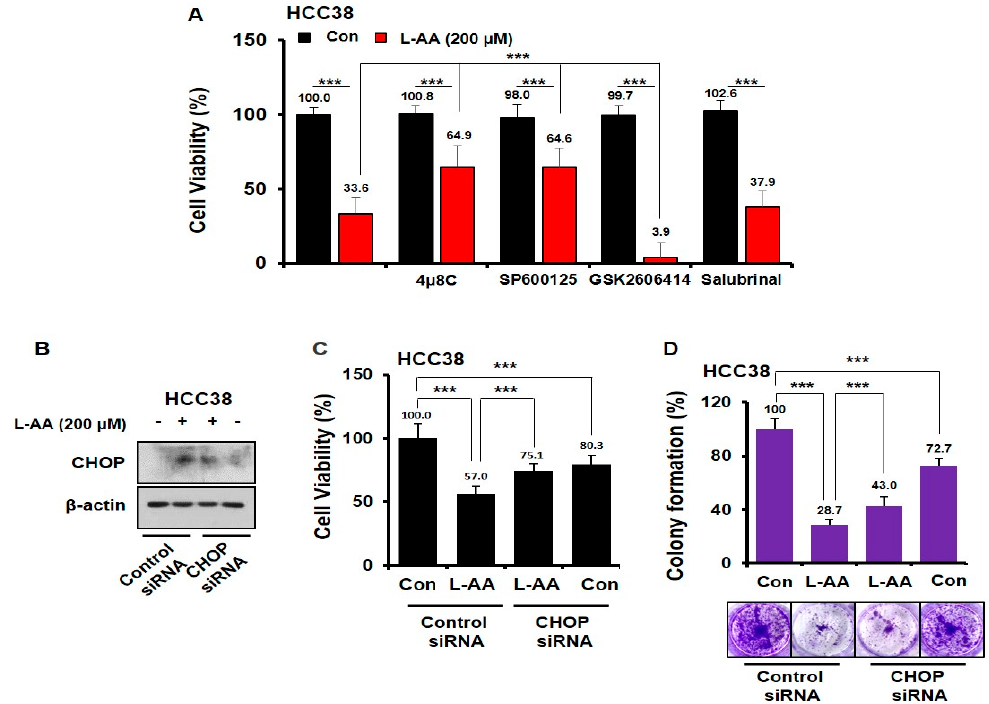
Figure 5. L-AA enhances IRE1 – c-Jun N-terminal kinase ( JNK )– CHOP -mediated cell death. ( A ) HCC-38